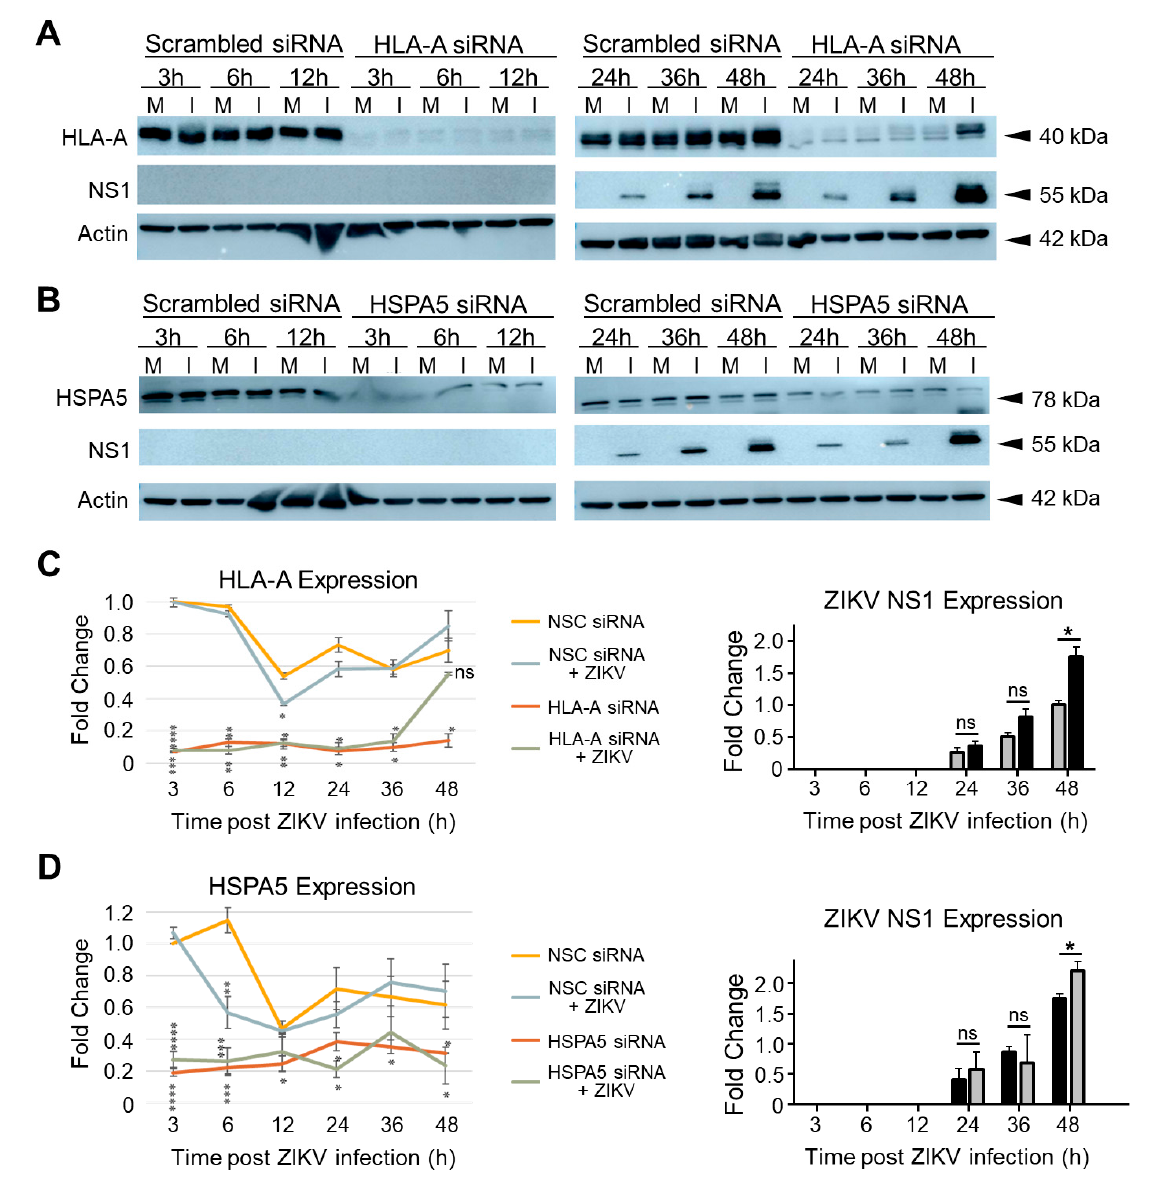
Figure 10. Expression of siRNA targeted proteins and ZIKV NS1 in ZIKV-infected siRNA-treated KD U251 cells at multiple timepoints. ( A ), ZIKV NS1 and HLA-A protein expression in scrambled siRNA vs. 50 nM HLA-A siRNA-treated, mock vs. infected U251 cells at 3, 6, 12, 24, 36 and 48 hpi. ( B ), ZIKV NS1 and HSPA5 protein expression in scrambled siRNA vs. 50 nM HSPA5 siRNA-treated mock (M) and infected (I) U251 cells at 3, 6, 12, 24, 36 and 48 hpi. ( C , D ) show quantification of bands for siRNA targeted proteins and ZIKV NS1 in ( A , B ), respectively. All error bars are standard deviations and 2-tailed Students t-test was used to measure statistical significance and calculate p -values. * p -value < 0.05, ** p -value < 0.01, *** p -value < 0.001, **** p -value < 0.0001. ns means not significant.